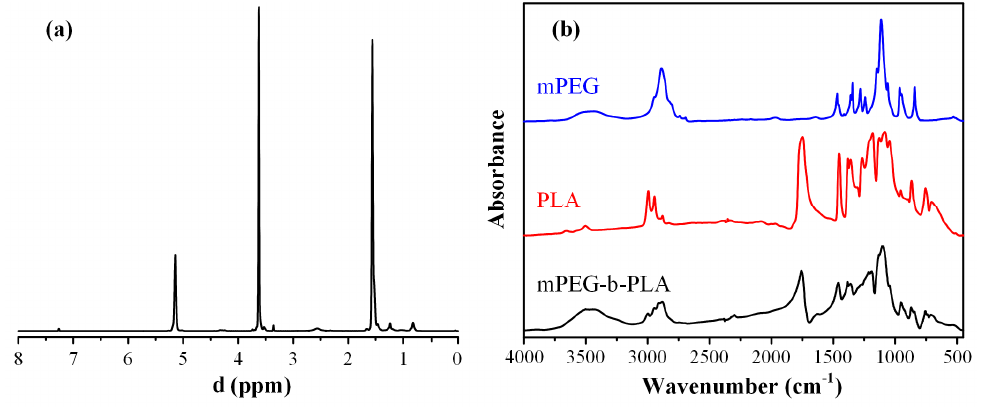
Figure 7. 1 H-NMR ( a ) and FT-IR spectra ( b ) of mPEG-b-PLA and